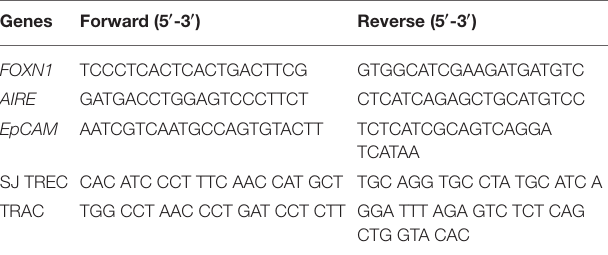
TABLE 1 | Quantitative real-time PCR primer sequences.